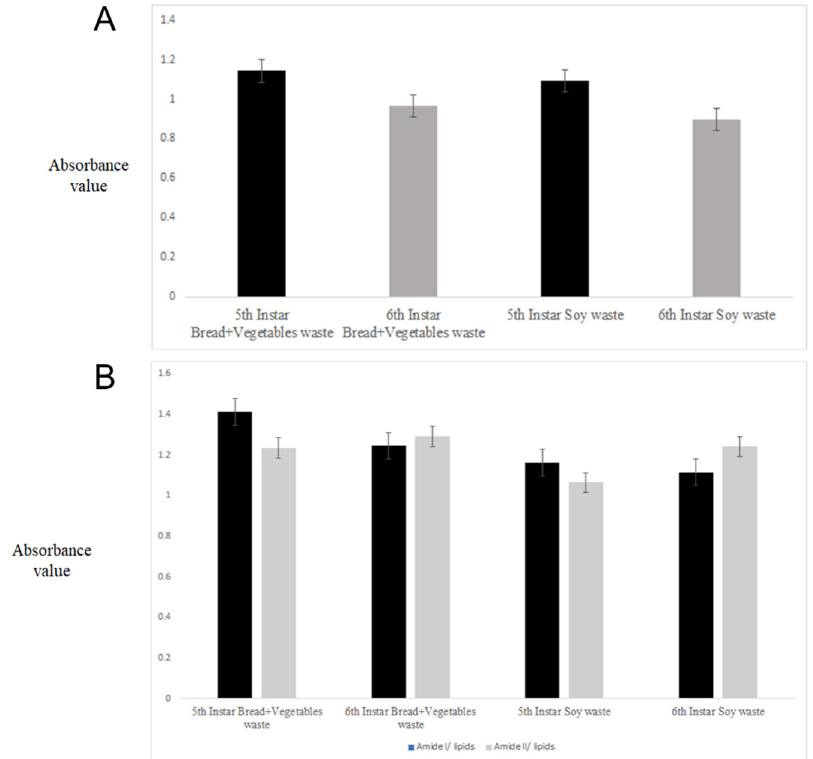
Figure 2. Ratios between the different absorbance values derived from the analysis of different in- stars (5th and 6th) and type of waste. Panel ( A ) is the ratio between the 1650 and 1540 cm − 1 frequen- cies; panel ( B ) is the ratio between the 1650 and 1540 cm − 1 frequencies and lipids (2921 + 2849 cm − 1 )